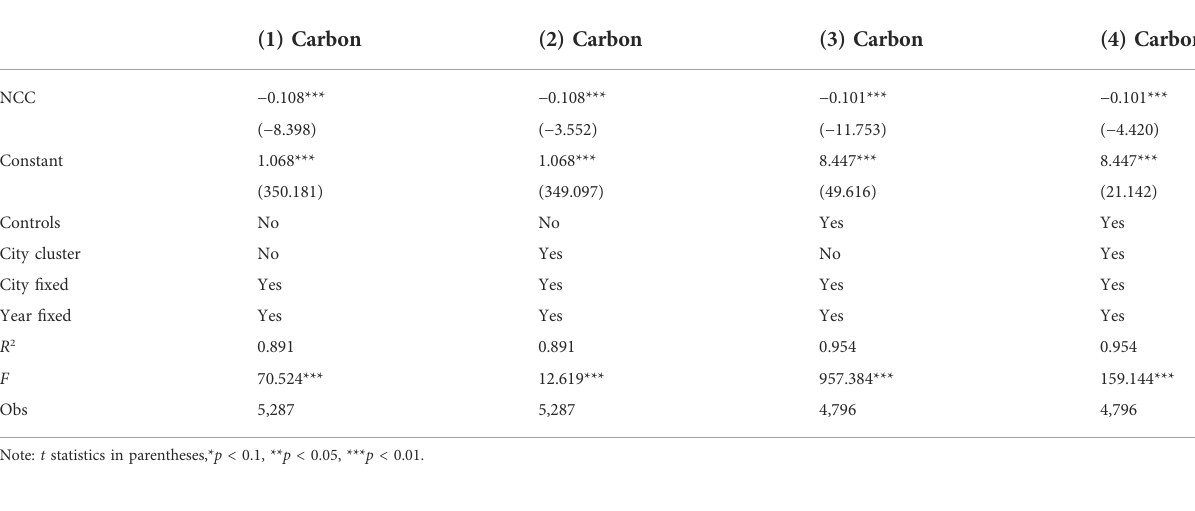
TABLE 2 The estimated results of the benchmark model.